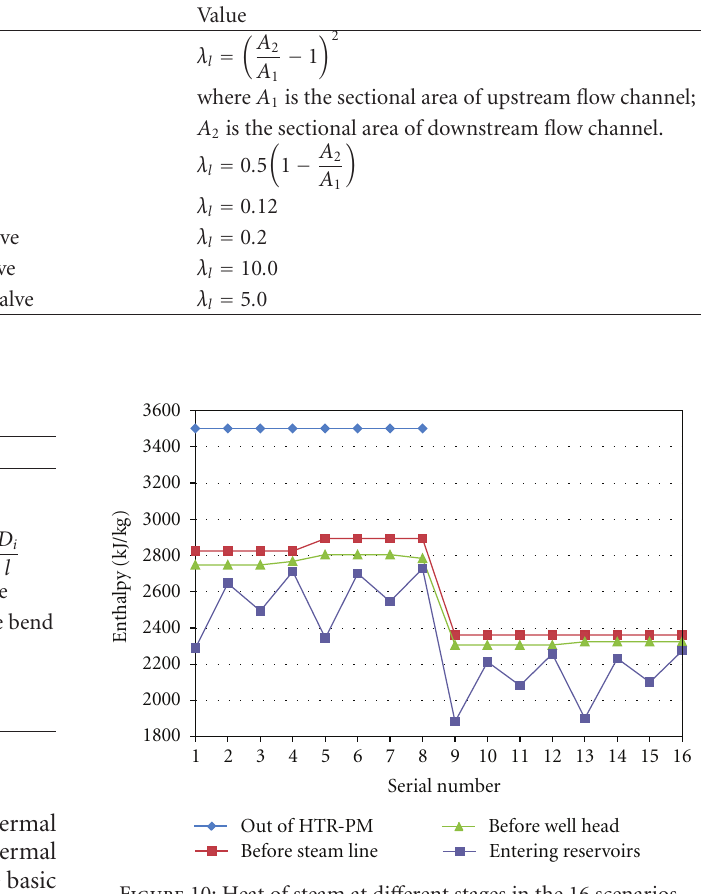
Figure 10: Heat of steam at di ff erent stages in the 16